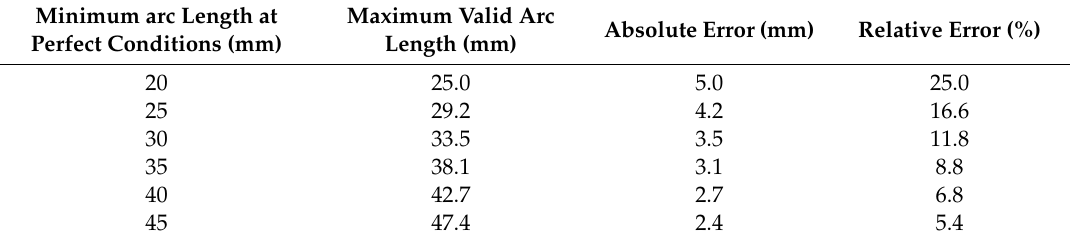
Table 1. Absolute and relative errors concerning the idealized straight downwards burning arc. Minimum arc Length at